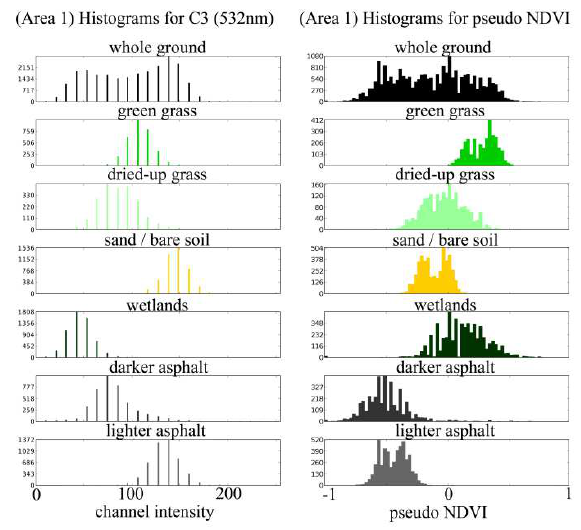
Figure 6. Class specific 8 bit scaled channel histograms for 532 nm wavelength laser signals and pseudo NDVI (counts/bin)